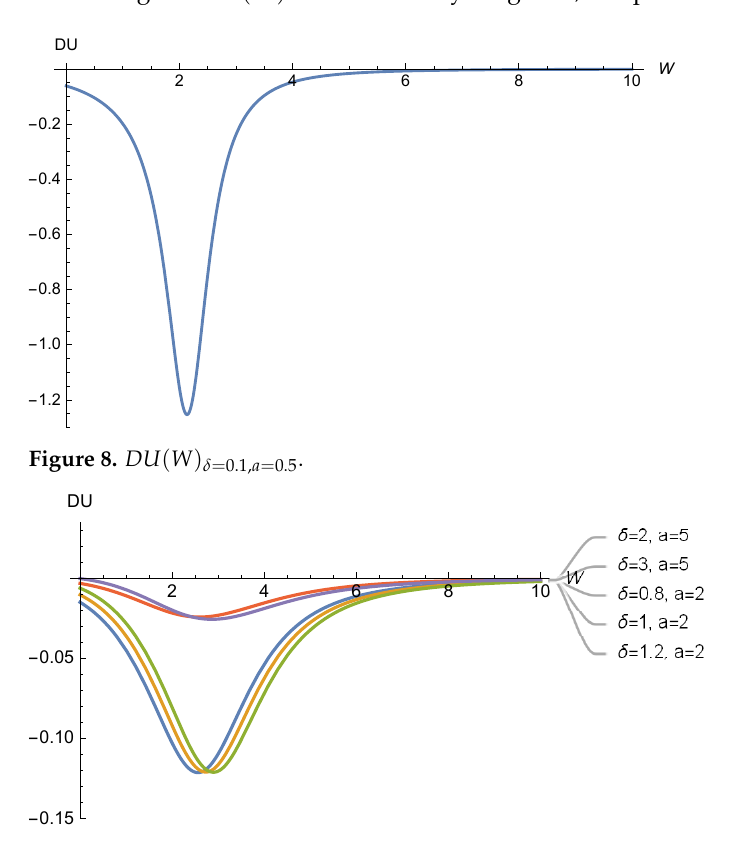
Figure 9. DU ( W ) for several combinations of δ and a such that δ > 0.73205 and a > a ∗ ( δ ) .